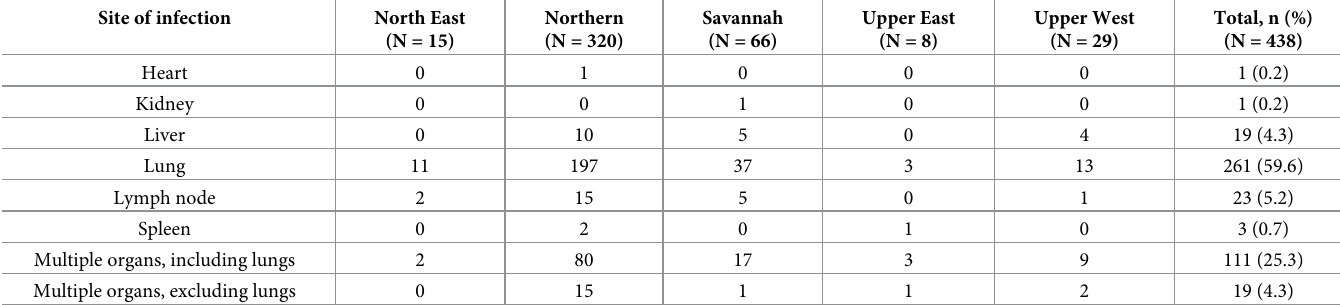
Table 1. Infected sites/organs and region where samples were obtained. Site of infection